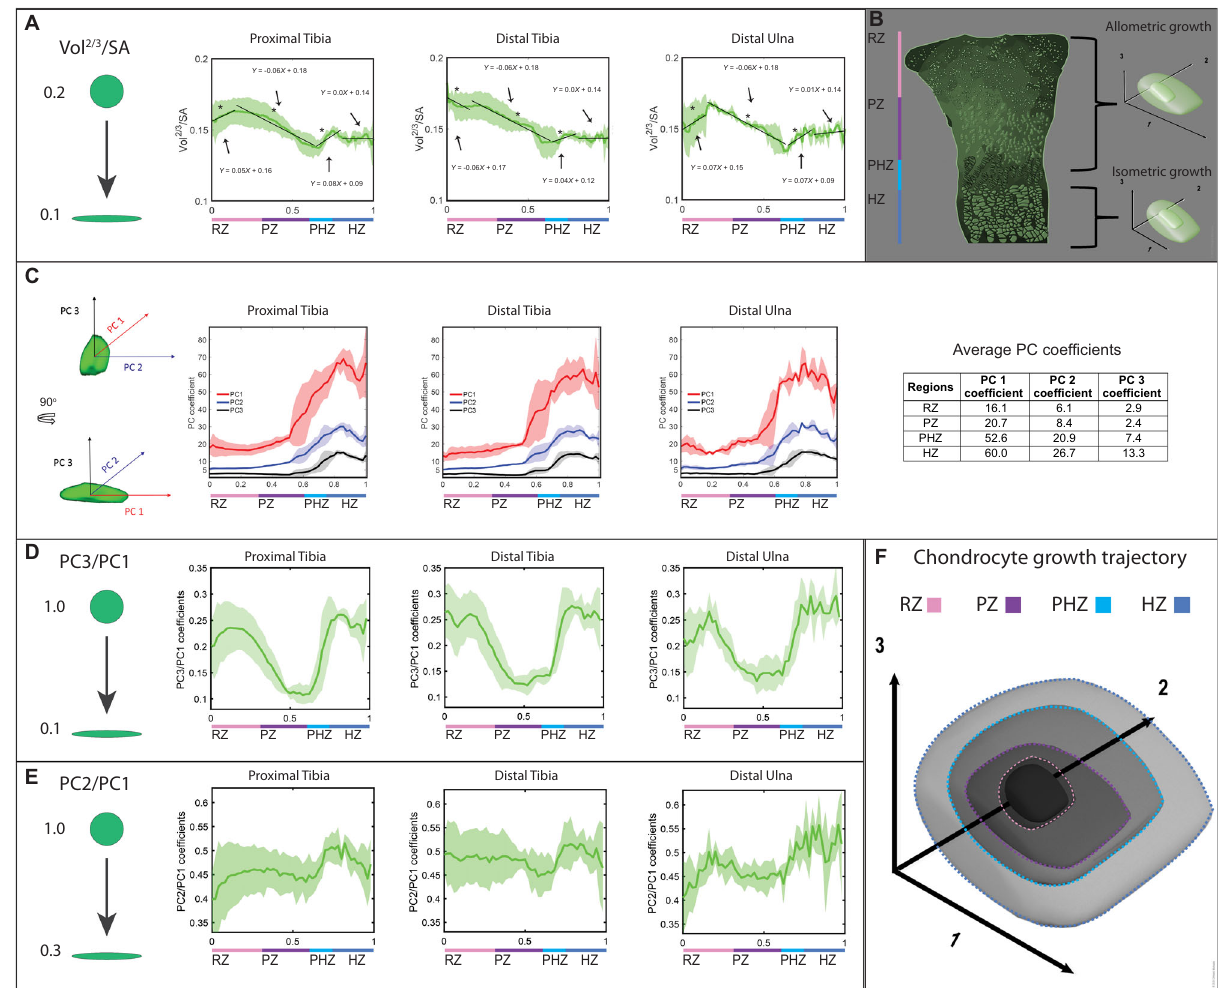
Fig. 3 Allometric and isometric growth behaviors de fi ne chondrocyte shape throughout differentiation. A The Vol 2/3 /SA ratio was plotted as a spatial pro fi le along the differentiation axis and regression lines were fi t for each change in growth behavior to determine if the growth was isometric (slope = 0) or allometric (slope ≠ 0). Slopes > 0 represent volume-dependent allometric growth, whereas slopes < 0 represent surface area-dependent allometric growth. In the PT and DU, RZ cells grew by volume-dependent allometric growth (PT slope = 0.05 p = 5.92e − 09 R 2 = 0.93; DU slope = 0.07 p = 7.37e − 04 R 2 = 0.6), while in the DT, RZ cells grew by surface area-dependent allometric growth (DT slope = – 0.06 p = 1.06e − 02 R 2 = 0.41). In the PZ, cells grew by surface area-dependent allometric growth (PT slope = – 0.06 p = 2.89e − 31 R 2 = 0.95; DT slope = – 0.06 p = 5.71e − 33 R 2 = 0.95; DU slope = – 0.06 p = 2.06e − 34 R 2 = 0.96), in the PHZ by volume-dependent allometric growth (PT slope = 0.08 p = 8.09e − 05 R 2 = 0.68; DT slope = 0.04 p = 3.11e − 04 R 2 = 0.62; DU slope = 0.07 p = 8.64e − 04 R 2 = 0.56), and in the HZ cells grew by isometric growth (PT slope = 0 p = 0.937 R 2 < 0.01; DT slope = 0 p = 0.903 R 2 < 0.01; DU slope = 0.01 p = 0.301 R 2 = 0.06). B Scheme illustrating that chondrocytes change their shape as they grow allometrically in the RZ, PZ, and PHZ, but maintain their shape while growing isometrically in the HZ. C , D Principal component analysis (PCA). C PC1 (red arrow) of the object represents the long cell axis, PC2 (blue arrow) the medium axis, and PC3 (black arrow) the short axis. Spatial pro fi les of PC 1, 2, and 3 show that they are signi fi cantly larger than one another and they are conserved among the three growth plates. The table shows the mean PC coef fi cients across all three growth plates per zone. D In all three growth plates, as cells differentiated from the RZ to the PZ, they decreased their PC3/PC1 ratio by half and then returned to the same ratio when they differentiated to the PHZ and HZ. E In the PT and DU, cells increased their PC2/PC1 ratio in the RZ and slightly decreased their ratio in the DT RZ. In all growth plates, the PC2/PC1 ratio was constant throughout the PZ, and increased as cells differentiate to the PHZ. The ratio at the end of the HZ is the same as in the RZ. F Scheme illustrating how each cell axis changes during growth and differentiation in the growth plate. Shaded region shows standard deviation from the mean between samples (PT and DT, n = 5; DU, n = 3). p -values were calculated by two-tailed Student ’ s t -test between mean slopes and slope = 0. Asterisks denote statistical signi fi cance. Abbreviations: PT, proximal tibia; DT, distal tibia; DU, distal ulna; RZ, resting zone; PZ, proliferative zone; PHZ, prehypertrophic zone; HZ, hypertrophic zone. Illustration by Chinami Michaels, © 2020 Chinami Michaels Biomedical Visualization Studio, ChinamiMichaels.com, provided under CC BY